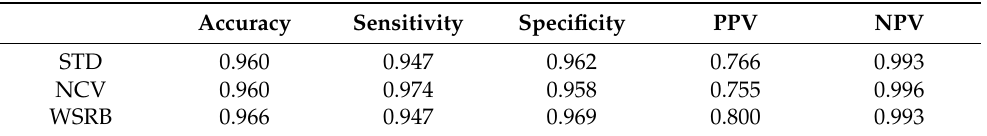
Table 2. Statistics of the accuracy, sensitivity, specificity, positive predictive value (PPV), and negative predictive value (NPV) of the three methods (STD, NCV, and WSRB).